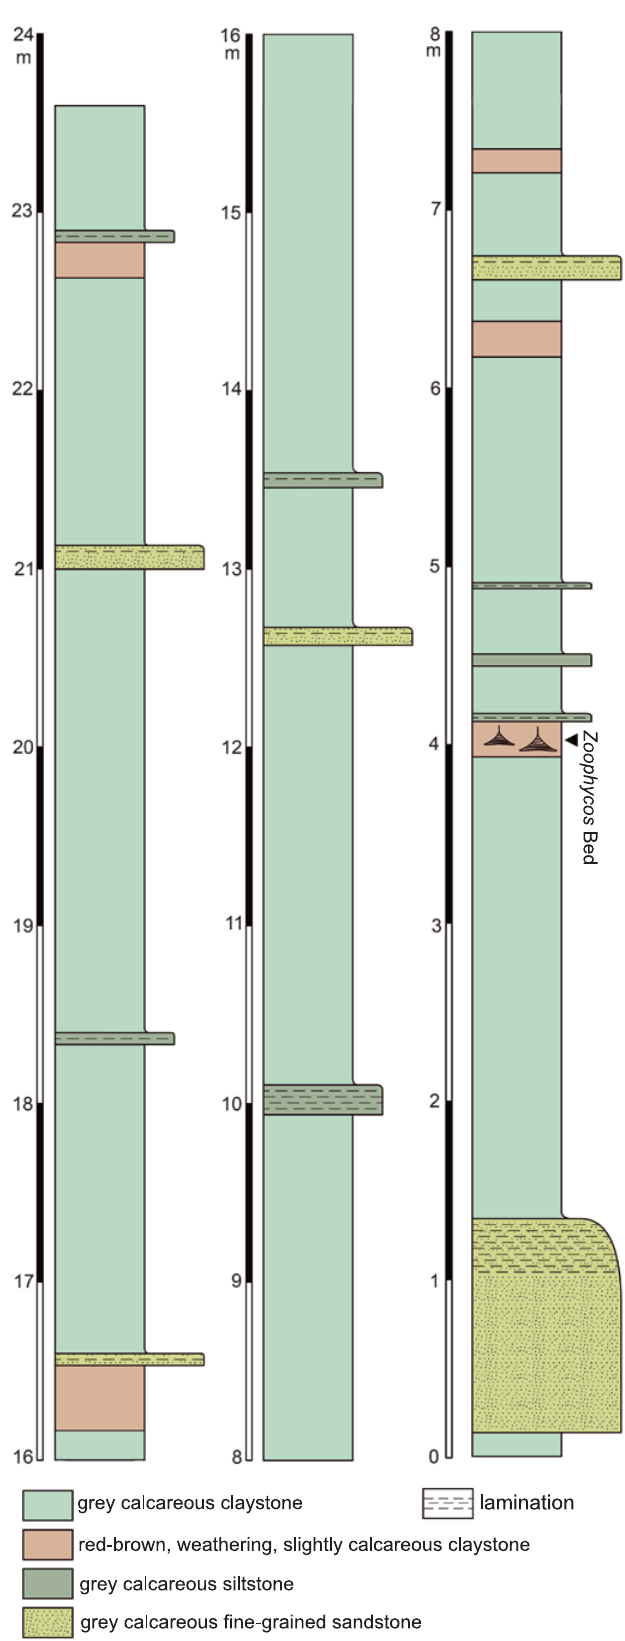
Fig. 2. Stratigraphic position of the Zoophycos Bed in the southern part of the studied locality.